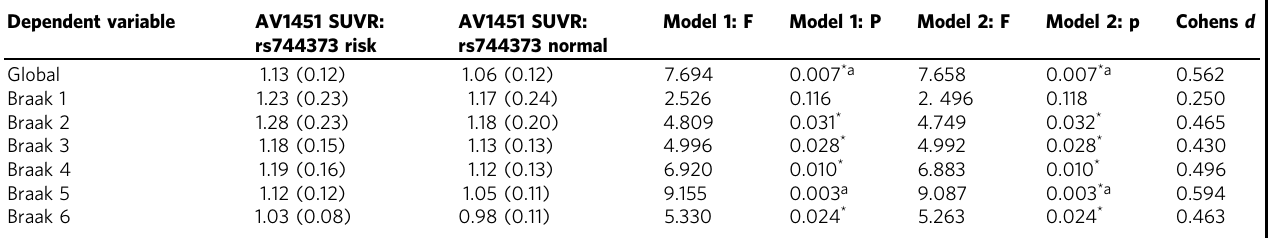
Table 2 BIN1 rs744373 risk allele as a predictor of AV1451 tau-PET SUVR Dependent variable